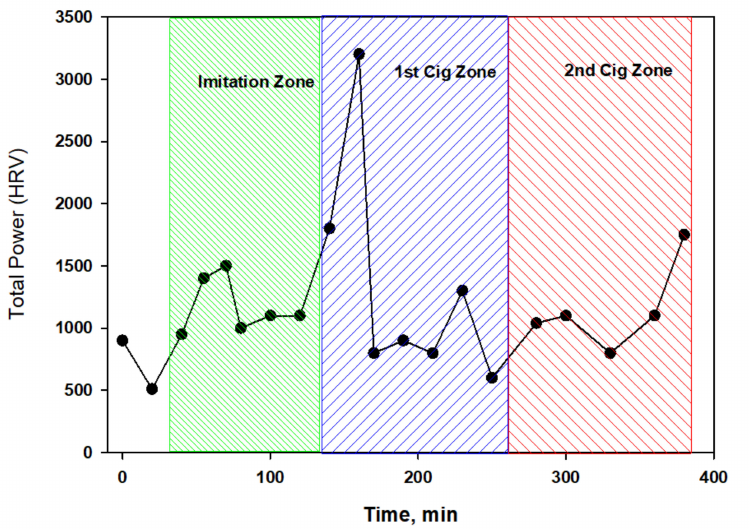
Figure 4. The dynamics of the total power spectrum (TP) during the testing of nicotine-free